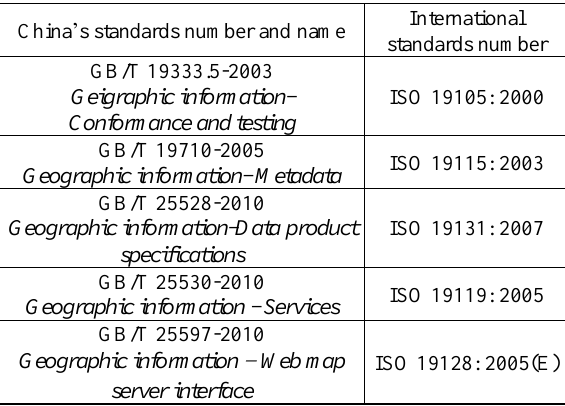
Table 1 . Some international standards adopted by